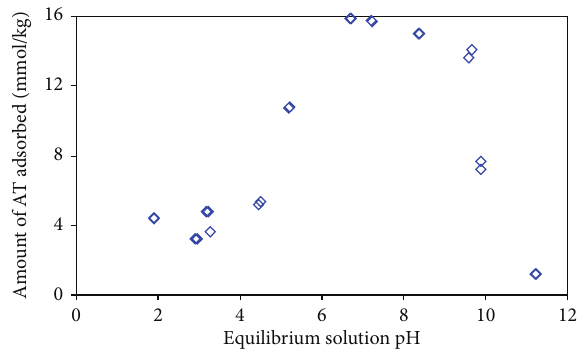
Figure 5: AT adsorption on kaolinite as affected by equilibrium solution pH.